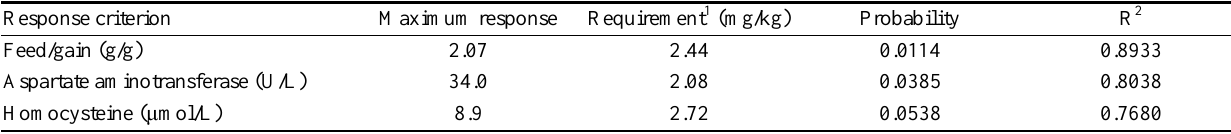
Table 4. Supplemental pyridoxine requirements of White Pekin ducklings from hatch to 28 days of age based on the quadratic regression